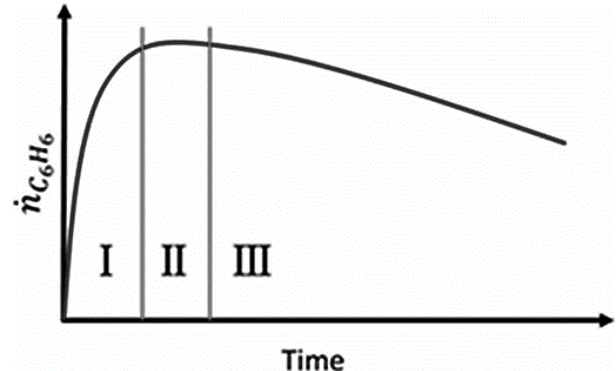
Figure 2. Benzene formation in typical DMA processes (I. Activation. II. Pseudo-steady state. III. Deactivation [7]). Copyright 2015 Wiley.